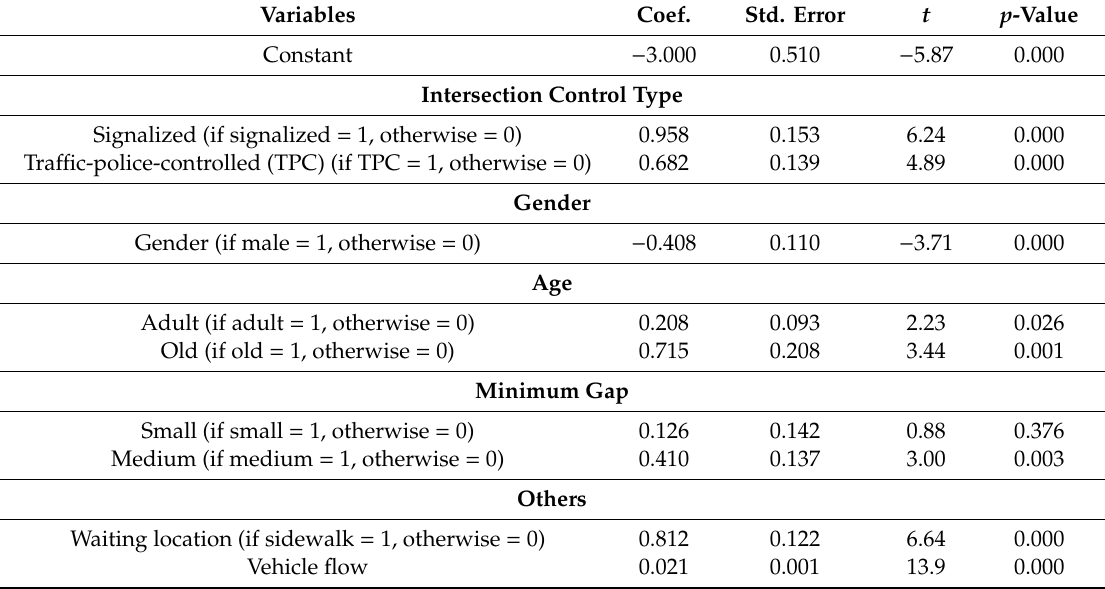
Table 10. Estimated parameter values of MLR